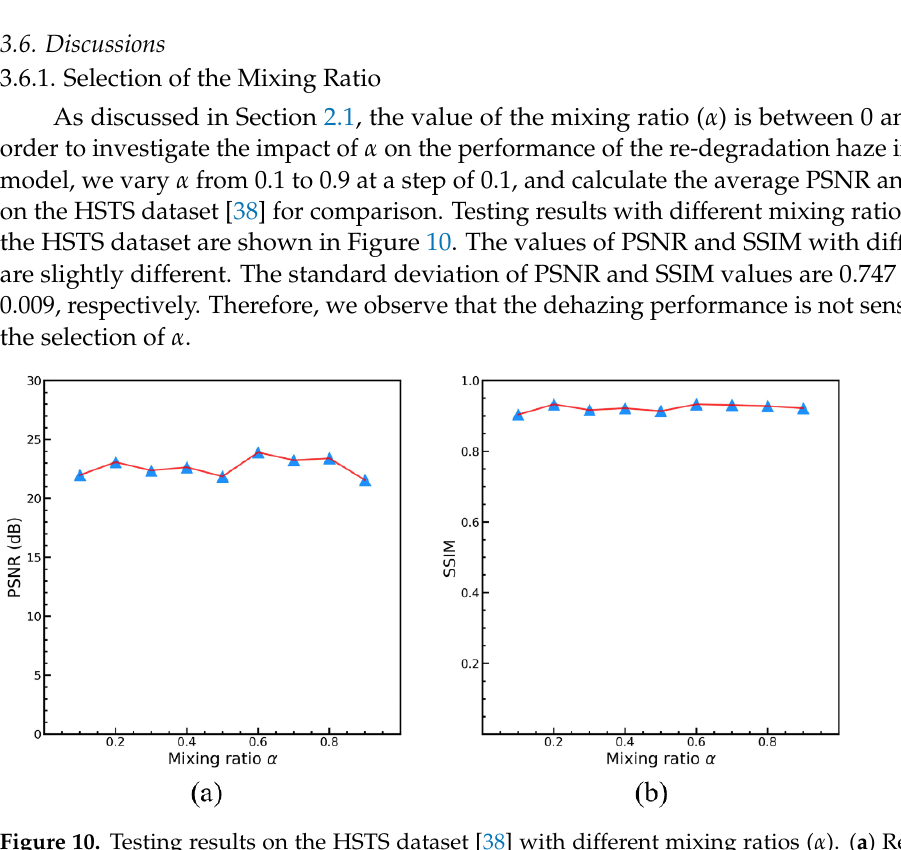
Figure 10. Testing results on the HSTS dataset [38] with different mixing ratios ( α ). ( a ) Results of PSNR. ( b ) Results of SSIM.